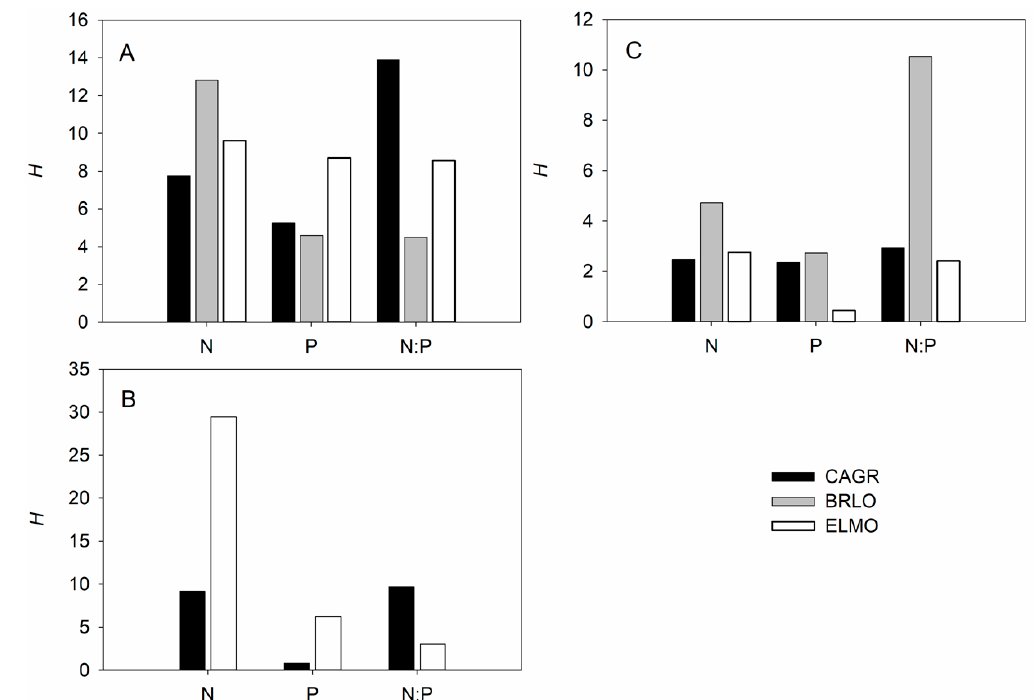
Figure 2. The stoichiometric homeostasis ( H ) values for N and P elements and their element ratios in the ( A ) leaf, ( B ) stem, and ( C ) root parts of different species. CAGR: Cautleya gracilis , BRLO: Briggsia longifolia , ELMO: Elatostema monandrum . B. longifolia has no stem and thus only stems of C. gracilis and E. monandrum were analyzed.